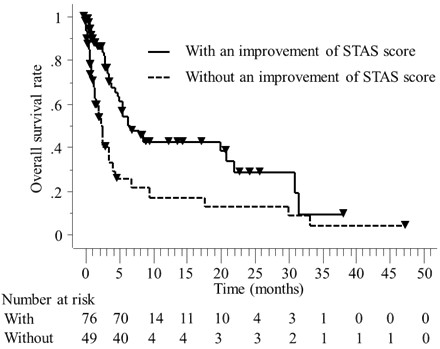
An improvement in the STAS score between pre- and postpalliative RT was found to be a statistically significant prognostic factor for overall survival after palliative RT (p = 0.0005).